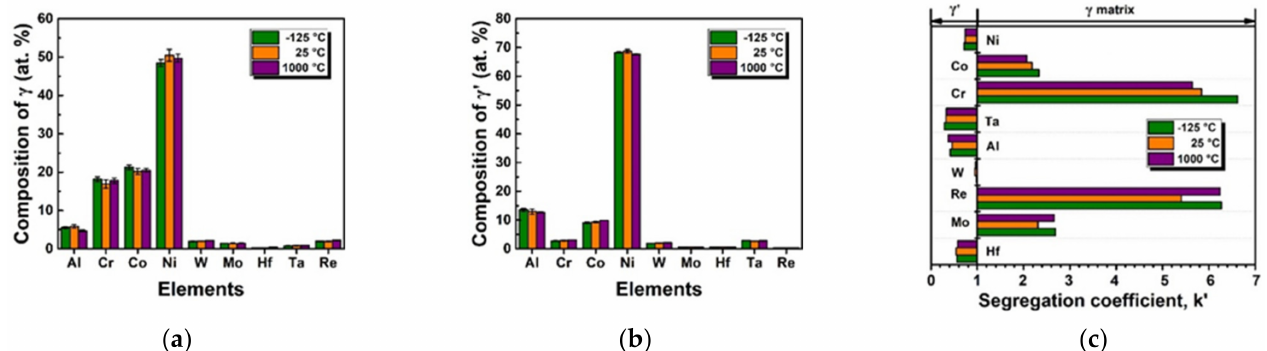
Figure 6. Measured compositions of γ matrix ( a ) and γ (cid:48) phase ( b ), and element segregation coefficient between γ (cid:48) and γ phases ( c ) in the dendrite cores at the cross sections close to the fracture surface of DZ406 superalloy tested at − 125 ◦ C, 25 ◦ C and 1000 ◦ C using STEM-EDX (at.